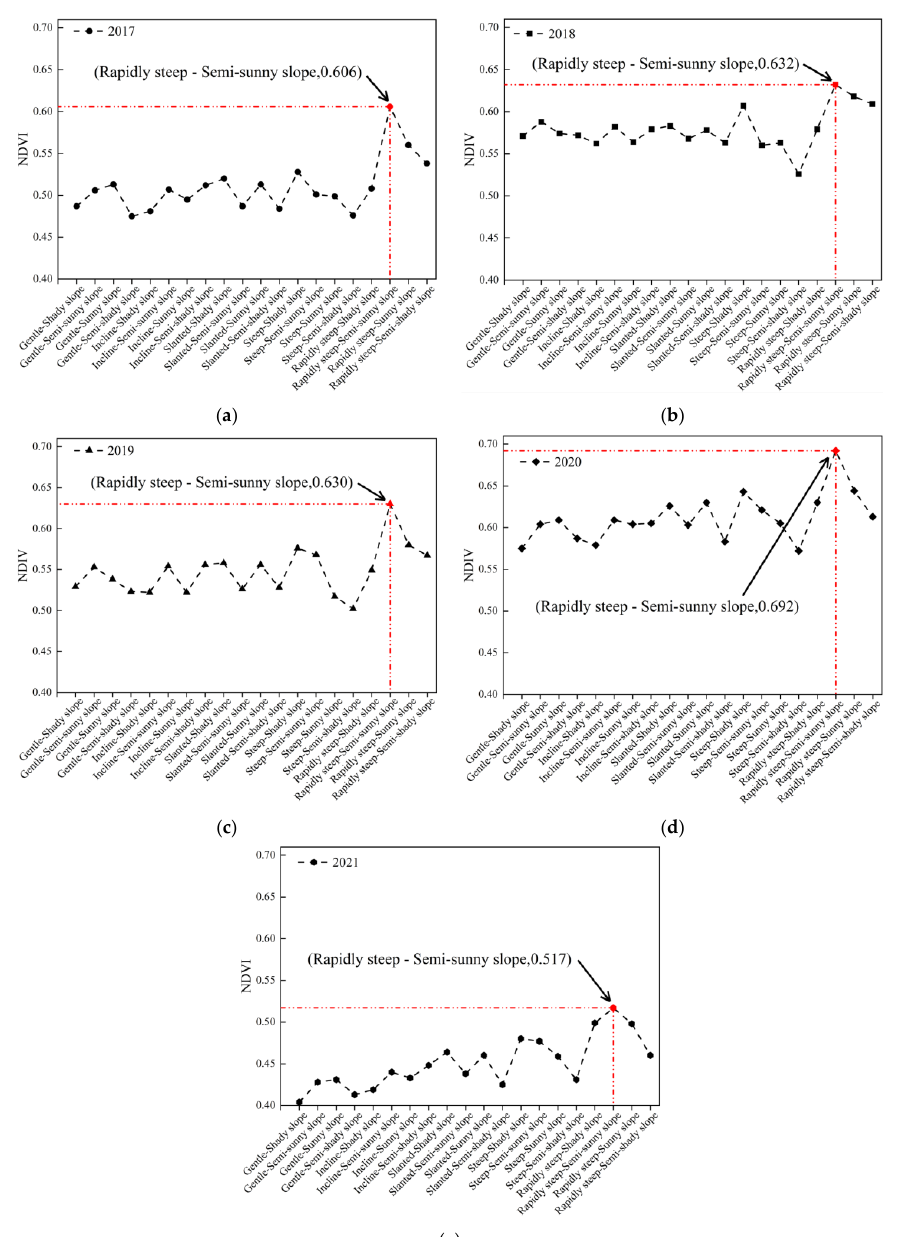
Figure 21. NDVI of 20 combinations in different years: ( a ) 2017; ( b ) 2018; ( c ) 2019; ( d ) 2020; ( e ) 2021.